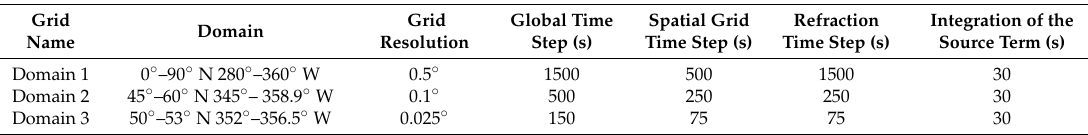
Table 1. WAVEWATCH III nested domain